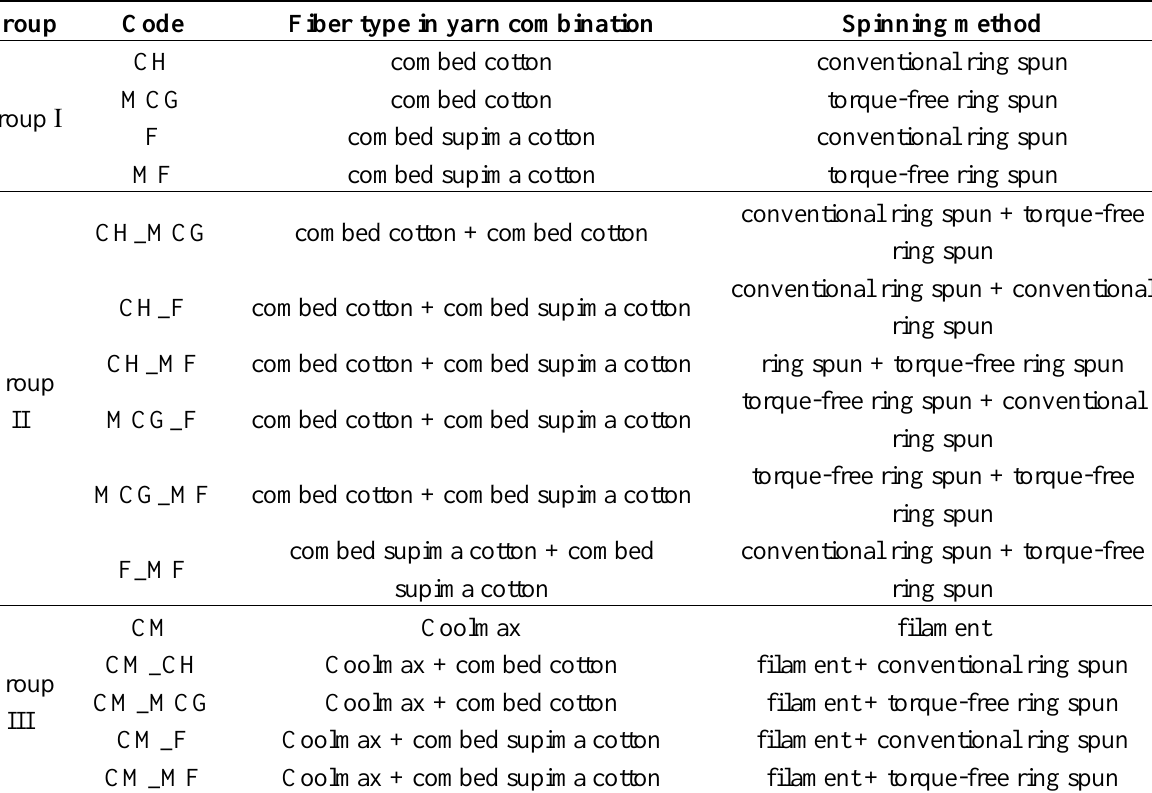
Table 2. Yarn combinations